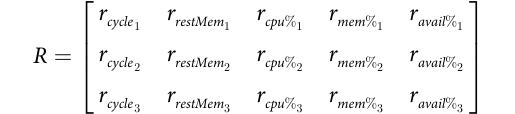
Table 1. The parameters of the ERP approach. Parameter Description Type CPU Cycle The CPU cycle refers to the CPU Clock Speed. Cost RAM Capability Cost